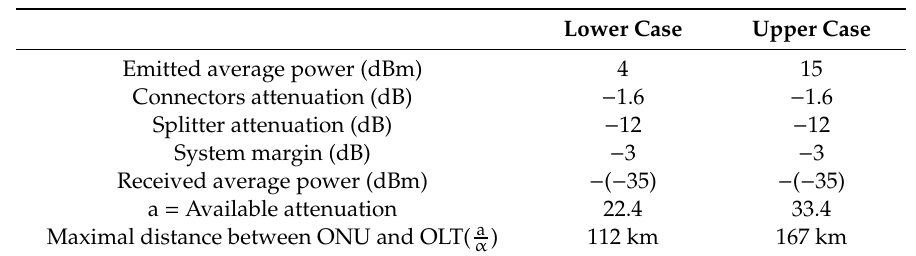
Figure 9. PON configuration used to perform power budget calculation. Table 3. Budget power calculation.